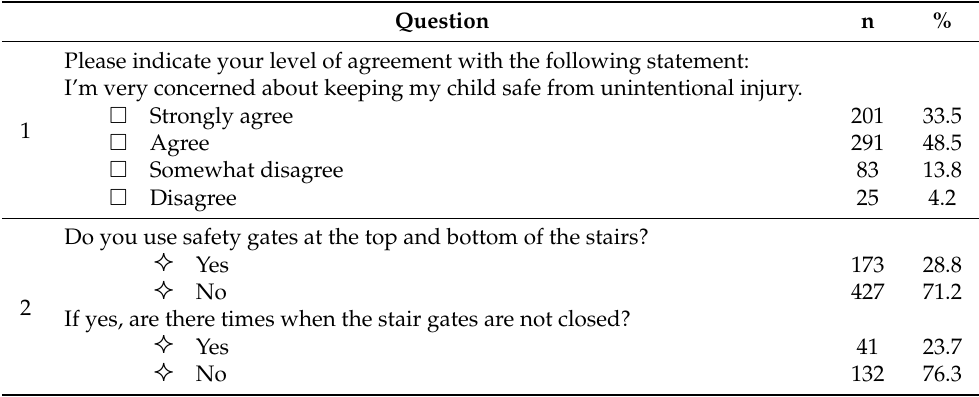
Table 1. Survey Table 1. Survey results.